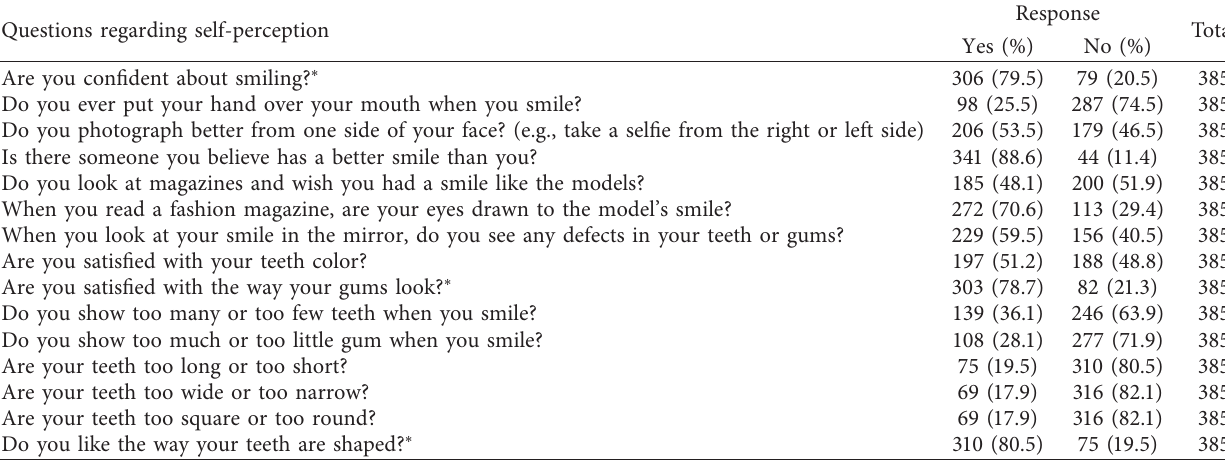
Table 2: Subjects’ responses regarding self-perception of dental esthetics.